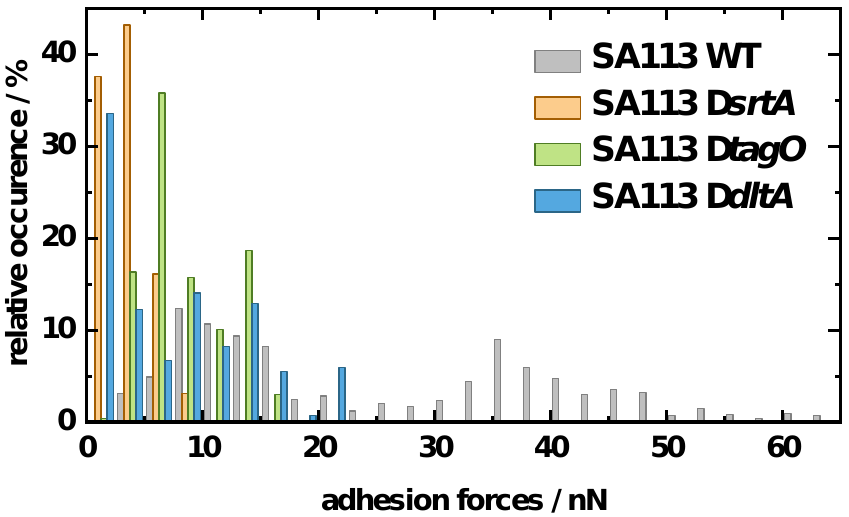
Figure A1. Overview histogram of all adhesion forces on OTS of 18 single SA113 ∆ srtA , 16 single SA113 ∆ tagO , and 17 single SA113 ∆ dltA cells. Additionally, the corresponding values of the SA113 wild-type population are shown in gray